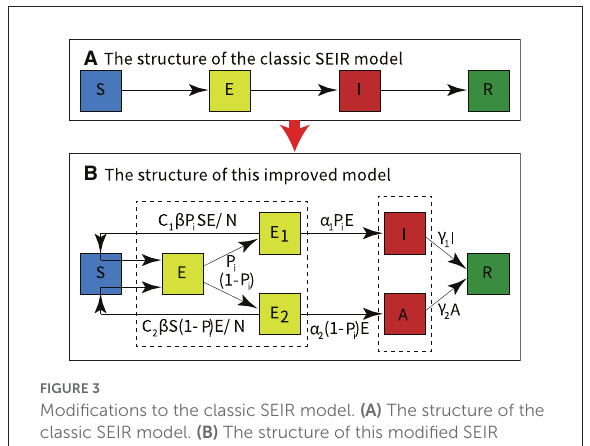
FIGURE3 Modifications to the classic SEIR model. (A) The structure of the classic SEIR model. (B) The structure of this modified SEIR